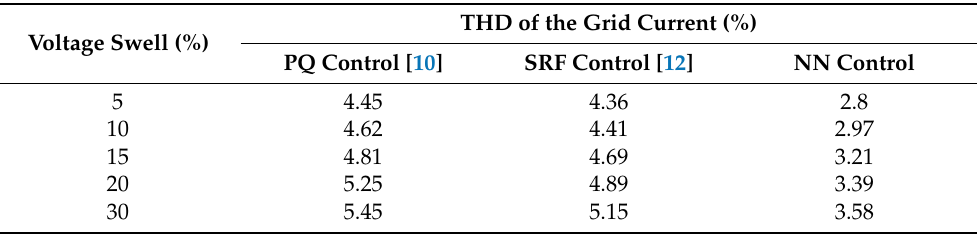
Table 3. Comparisons Grid current THD for NN controller with PQ and SRF control for various voltage swell conditions.